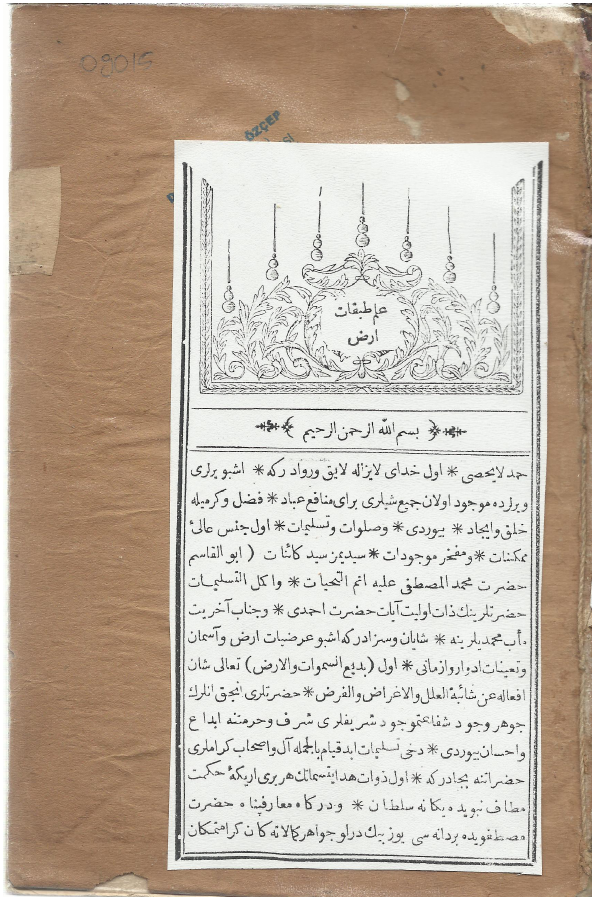
Figure 8. First geology book in the Ottoman Empire, written by Mehmet Ali Fethi: ˙Ilmü Tabakatülarz